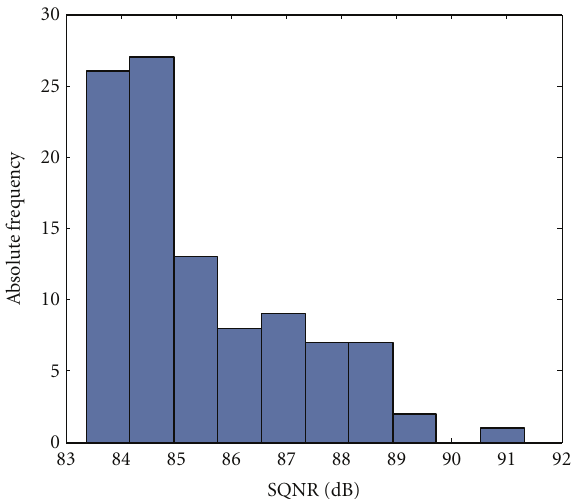
Figure 13: SQNR performance histogram of the ST/DDST architecture for 100 Monte Carlo trials.